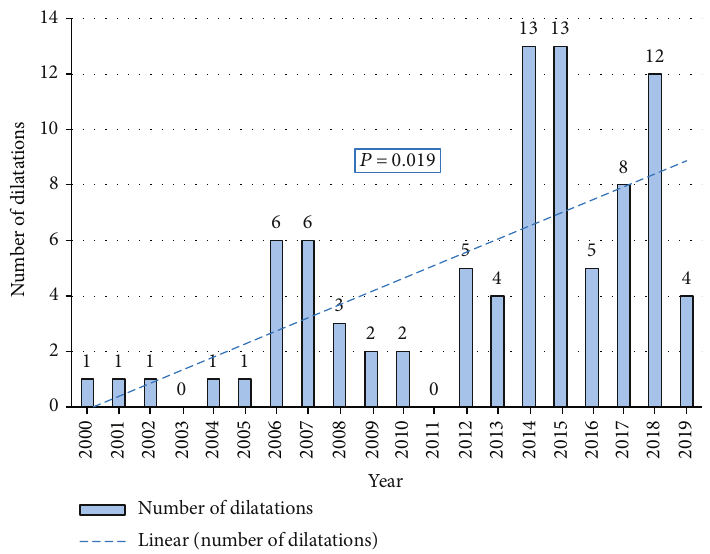
Figure 2: Numbers of endoscopic esophageal dilatations per year performed in children with esophageal strictures, 2000 – 2019.